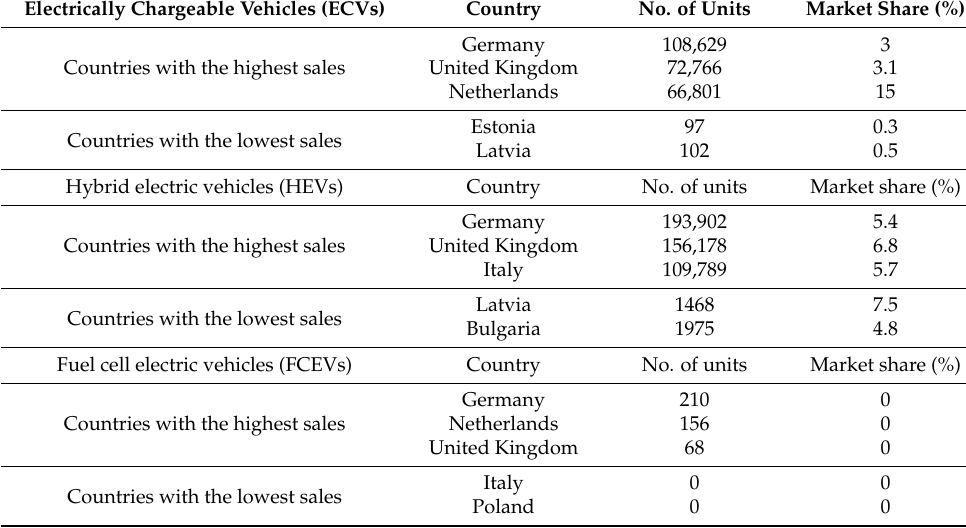
Table 3. Diversification of EVs’ numbers and market share in the European states. Electrically Chargeable Vehicles (ECVs) Country No. of Units Market Share (%) Countries with the highest sales Countries with the lowest